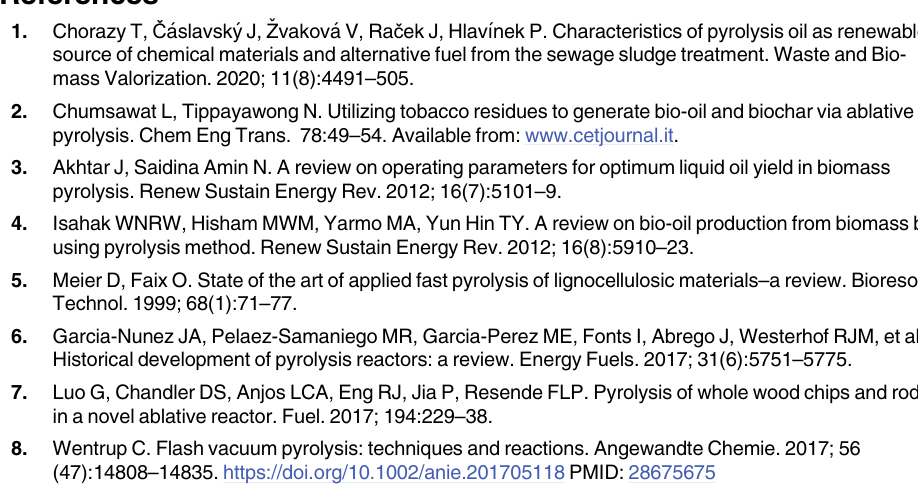
S1 Fig. Dispersion graphics of organic oil in different temperature (a) 450˚C, (b) 500˚C, (c) 550˚C and (d) 600˚C. S2 Fig. Three-dimensional diagrams of organic oil in different temperature (a) 450˚C, (b) 500˚C, (c) 550˚C and (d)